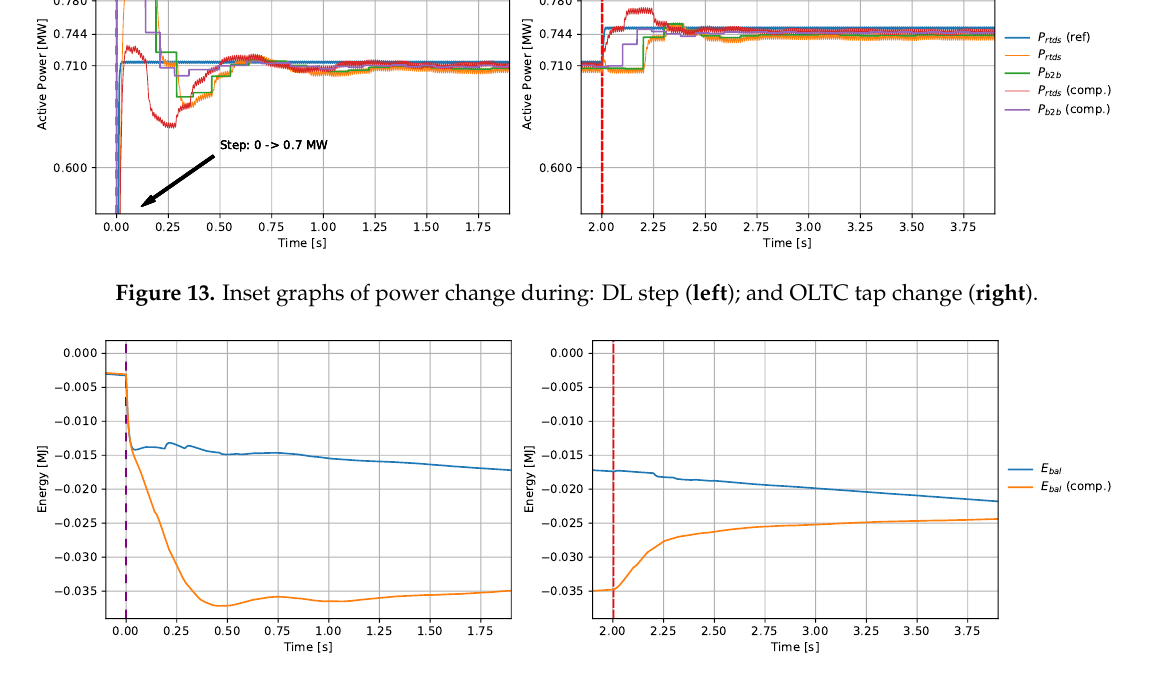
Figure 14. Inset graphs of interface energy during: DL step ( left ); and OLTC tap change ( right ). A full version of the results can be found in Figure A1 in Appendix